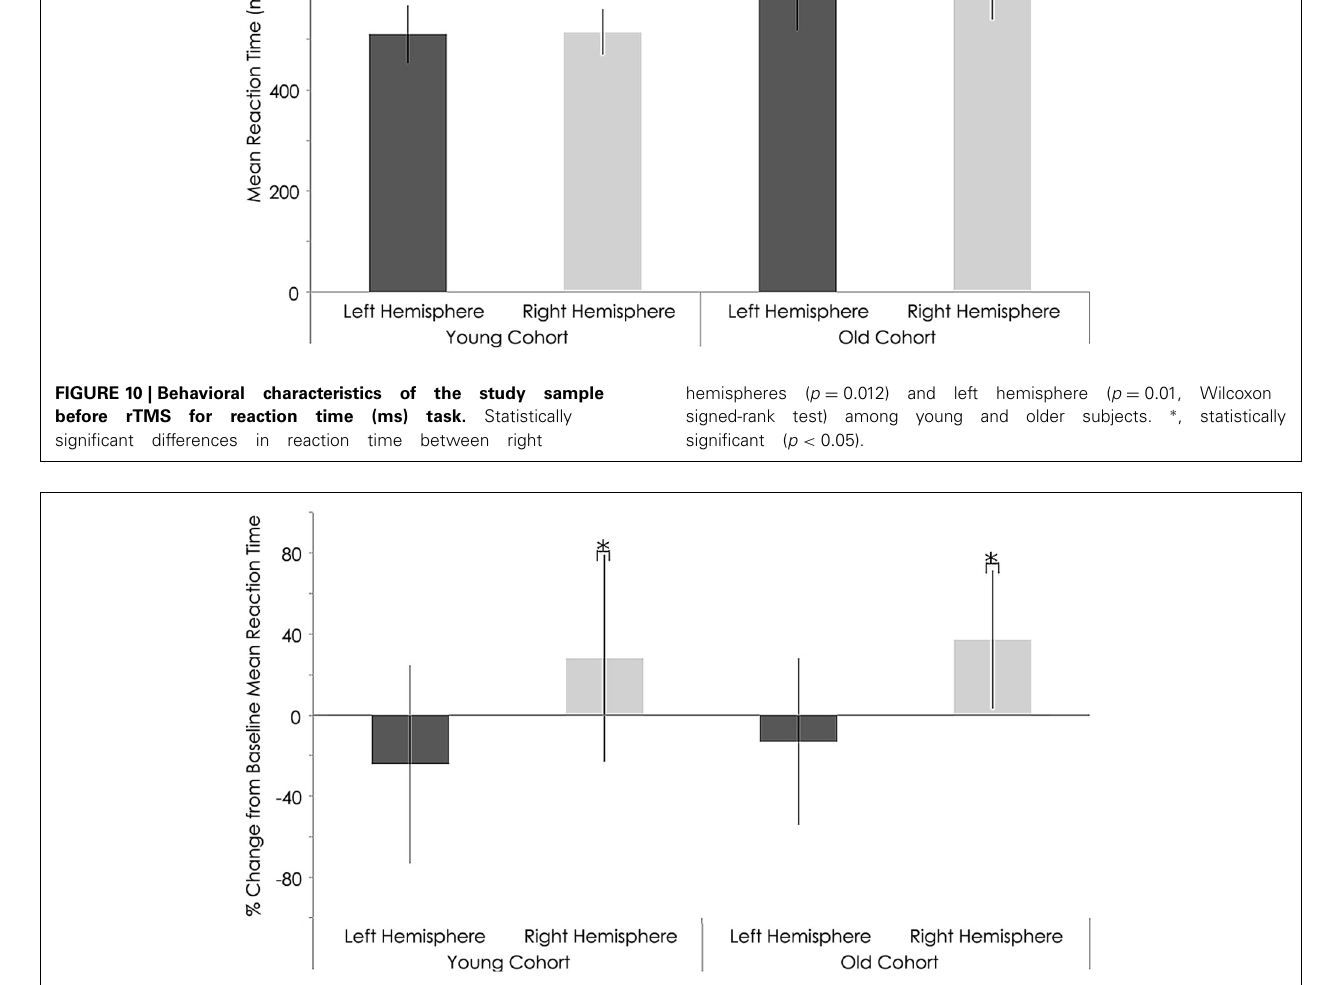
FIGURE 11 | Behavioral characteristics of the study sample after rTMS for reaction time (ms) task. Statistically significant increase in reaction time right hemispheres among young ( p = 0 . 002) and older subjects ( p = 0 . 016; Wilcoxon signed-rank test). ∗ , statistically significant ( p < 0 . 05).